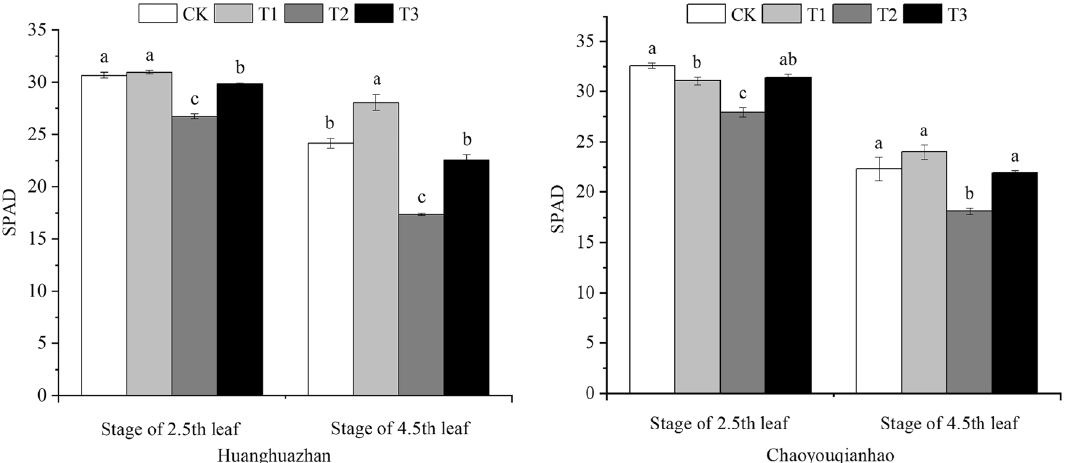
Figure 1. Effect of soaking with BR on the SPAD of rice seedlings under salt stress. Different lowercase letters indicate significant differences at the P < 0.05 level. CK: soaking with distilled water + watering 0 g L −1 NaCl. T1: soaking with BR + watering 0 g L −1 NaCl. T2: soaking with distilled water + watering 3 g L −1 NaCl. T3: soaking with BR + watering 3 g L −1